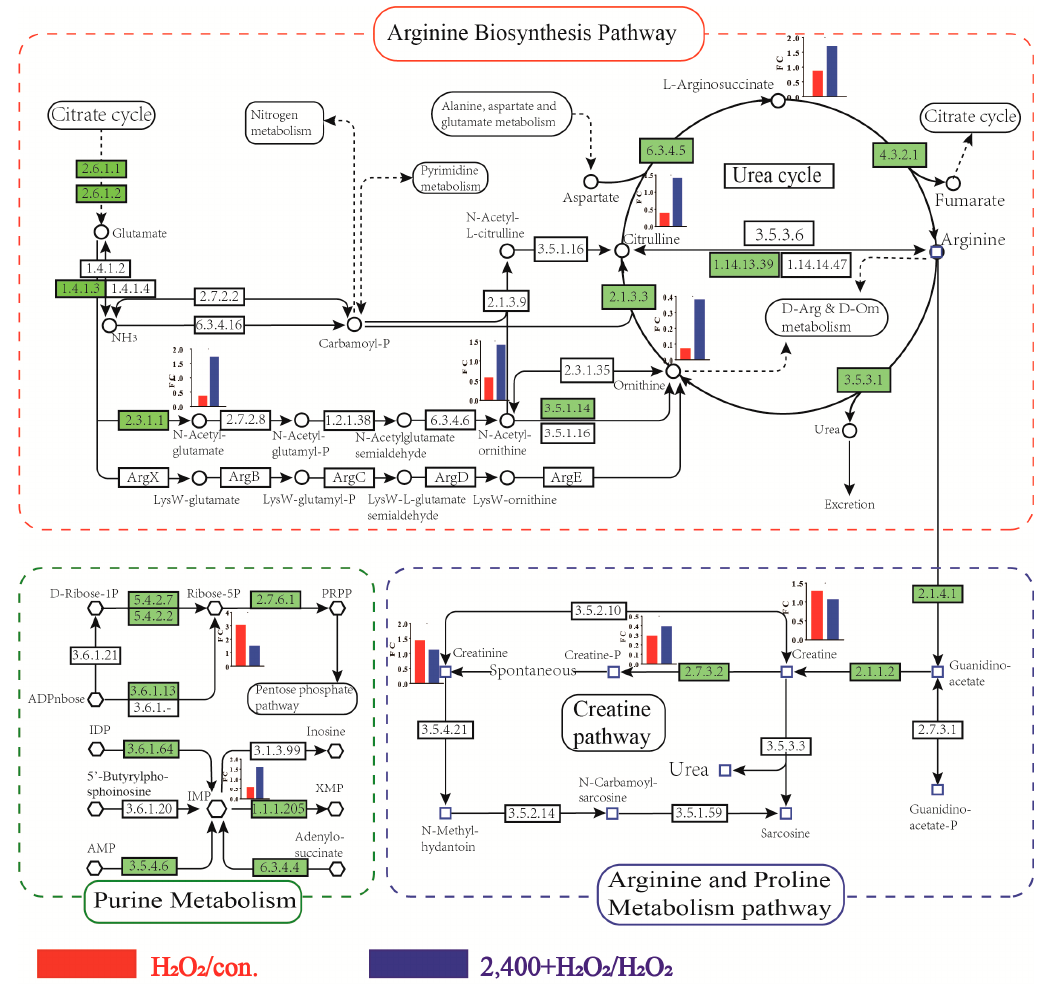
Figure 7. H 2 O 2 and chrysanthemum extract regulated metabolic pathway. FC: fold change; Con.: control; H 2 O 2 : 7 mM H 2 O 2 ; 2400 + H 2 O 2 : 2400 μ g/mL chrysanthemum extract and 7 mM H 2 O 2 . Green represents the presence of enzymes in the human body.